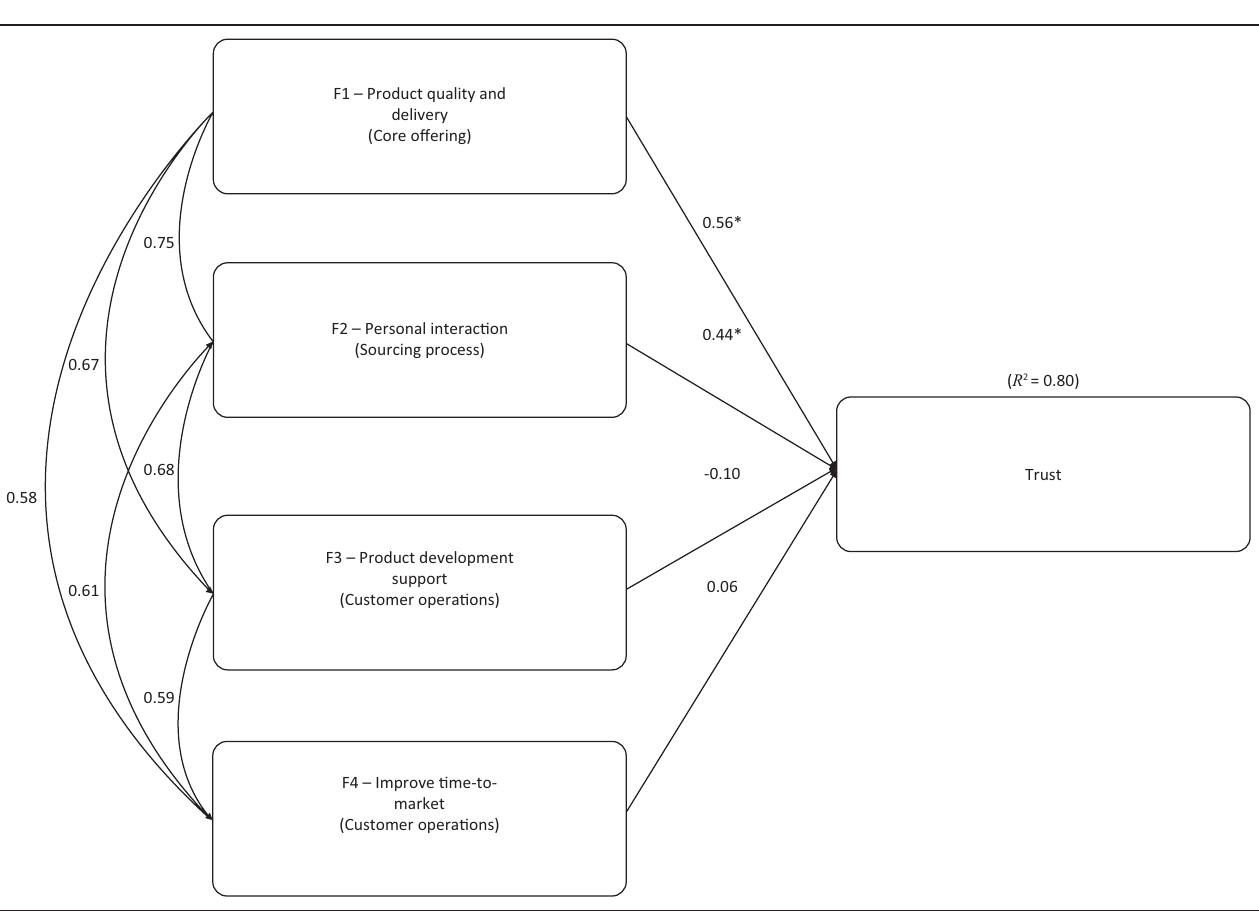
FIGURE 2: Results of the path analysis. Standardised coefficients are